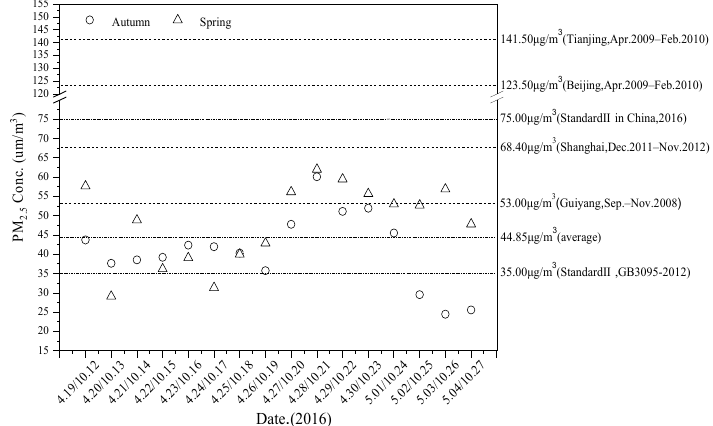
Figure 2. The daily mass concentration of PM 2.5 during sampling.